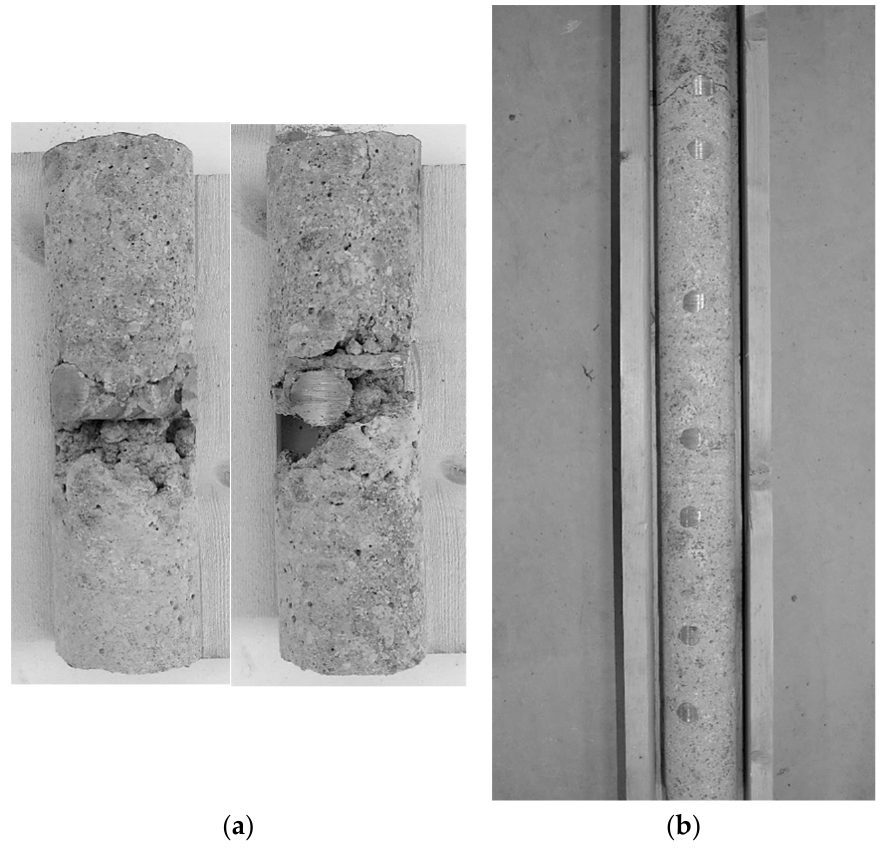
Figure 9. Cores vertically drilled from the foundations: ( a ) core drilled on the inclined surface at a plastic settlement crack, and ( b ) core drilled on the pedestal.